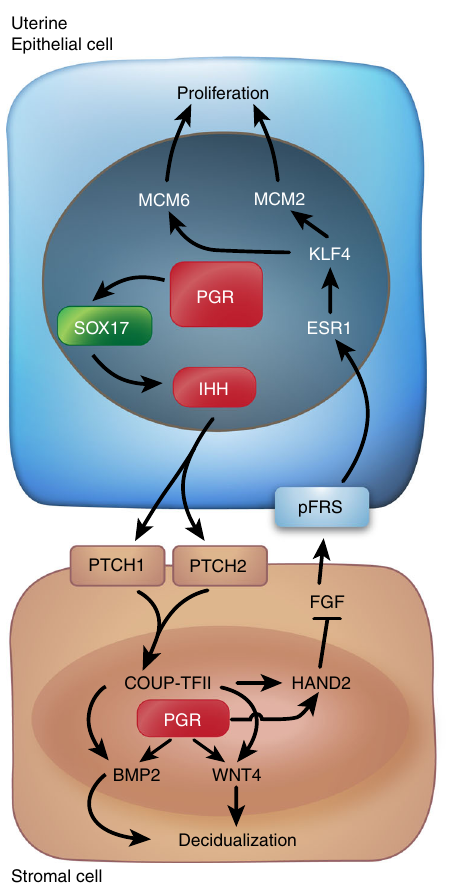
Fig. 8 SOX17 regulates IHH signaling pathway to govern uterine epithelial – stromal interactions during the window of